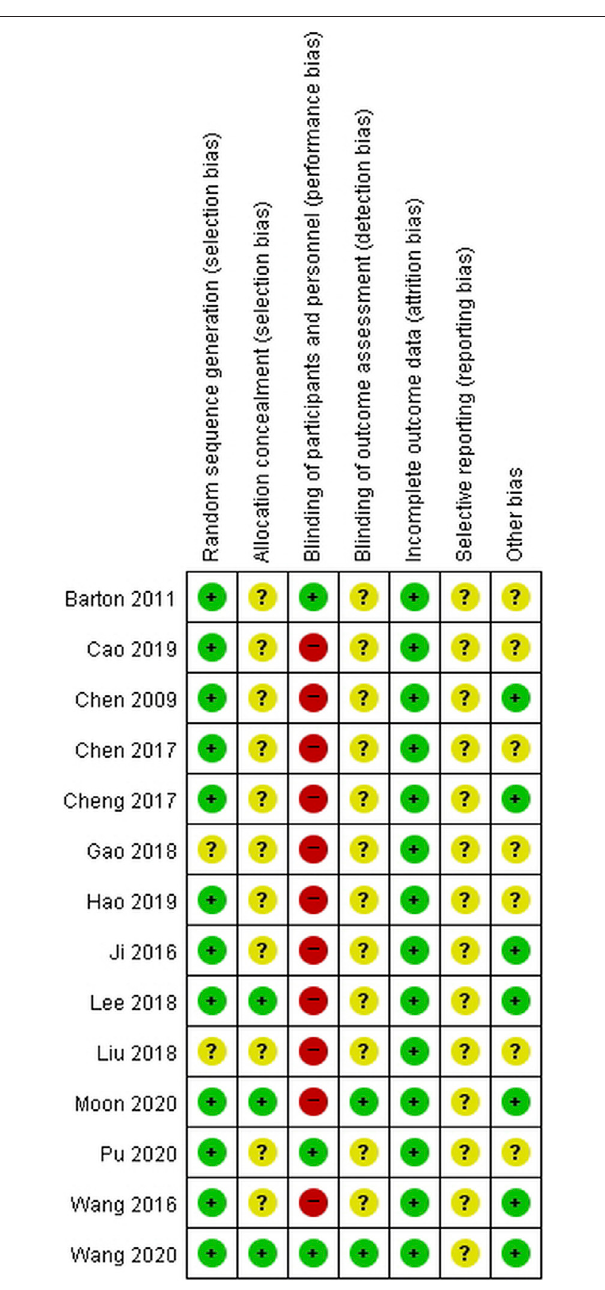
FIGURE 2 | Risk of bias summary. +, low risk of bias; ?, unclear of bias; − , high risk of bias.